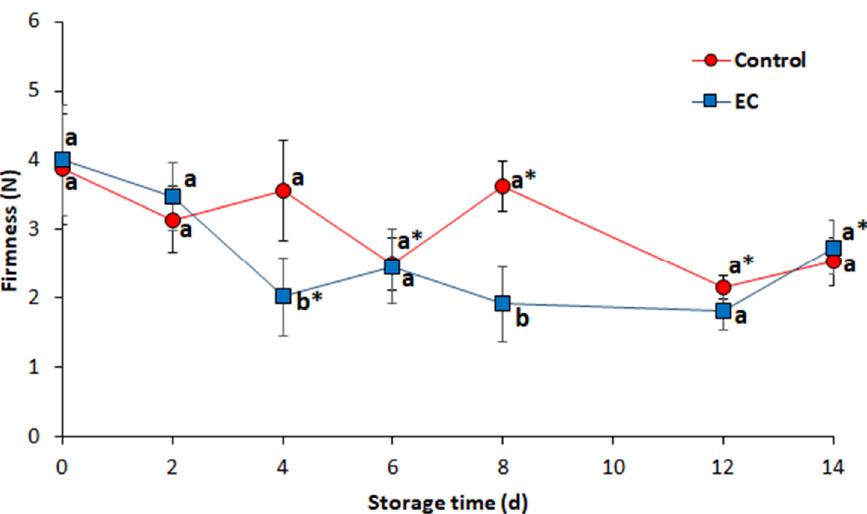
Figure 3. Firmness of chicken breast fillets with and without the antimicrobial coating stored at 4 °C. Different letters indicate significant differences between treatments for the same sampling day. The asterisk indicates significant differences between consecutive measurement days for the same treatment according to Tukey’s HSD test ( p ≤ 0.05). Standard deviation included ( n = 3).